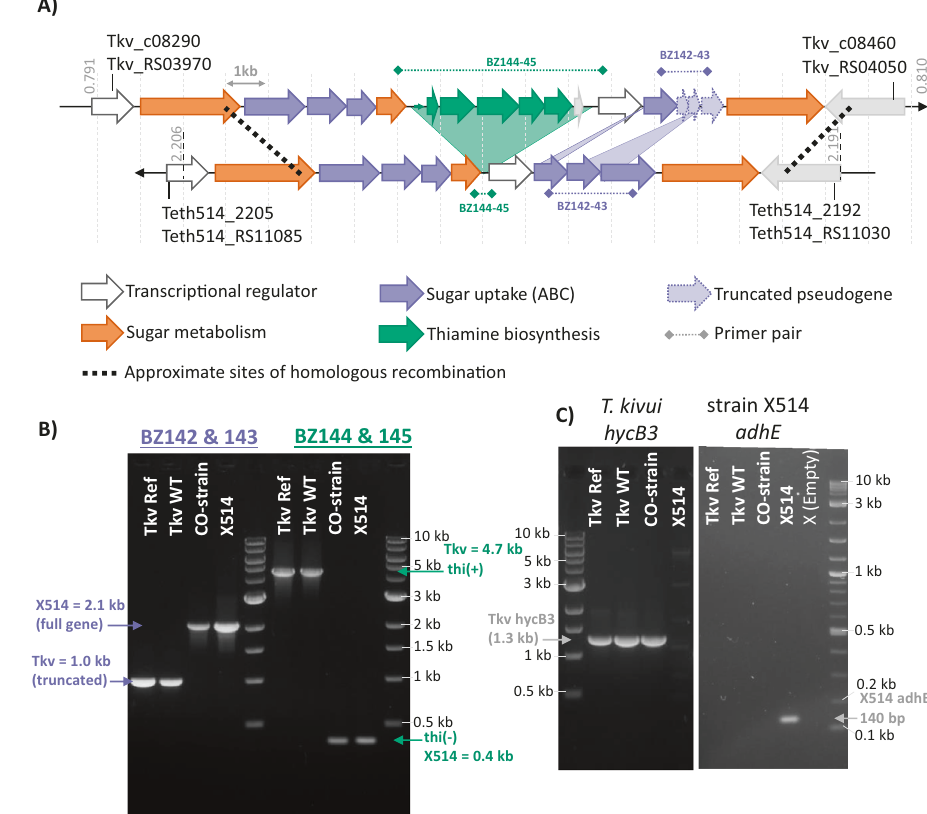
Fig. 2 Comparison of highly mutated genome regions of T. kivui and Thermoanaerobacter sp. strain X514 con fi rm a horizontal gene- transfer event. A Alignment of the T. kivui and Thermoanaerobacter sp. strain X514 genomes reveals high synteny and sequence homology in the region with the majority of SNPs. B Agarose gel electrophoretic separation of PCR products of the ABC-sugar import transporter subunits (purple) and of the thiamine biosynthesis operon (green), obtained by using primer combinations BZ142 and BZ143, or BZ144 and BZ145, respectively. C PCR ampli fi cation of the hycB3 gene speci fi c to T. kivui , and adhE gene speci fi c to strain X514. Genomic DNA puri fi ed from: Tkv Ref = T. kivui DSM2030; Tkv-WT = T. kivui “ wild type ” ( Δ pyrE ) used in this study; CO-strain = T. kivui adapted to CO ( Δ pyrE ); X514 = Thermoanaerobacter sp. strain X514. Marker is NEB 1 kb Ladder, or NEB 1 kb PLUS Ladder (for adhE Sanger sequencing. The resulting PCR product lengths for the CO- strain were not consistent with the published genome (Fig. 2B) as, in addition to the SNPs detected by genome sequencing, several larger insertions and deletions were present. From the PCR, it is apparent that the CO-strain has a roughly 1 kb insertion in the second ABC-transporter cluster (primers BZ142-143) as well as a greater than 4 kb deletion in the thiamine biosynthesis operon (primers BZ144-145) (Fig. 2A). Interestingly, Sanger sequencing of the anomalous length PCR products revealed perfect sequence agreement to the genome of Thermoanaerobacter sp. strain X514, a related strain that differs signi fi cantly in its metabolic properties. Strain X514 produces ethanol from glucose by fermentation as well as other alcohols from organic acids [29] but it does not contain the Wood- Ljungdahl pathway for CO 2 reduction and fi xation, and it therefore does not grow on H 2 + CO 2 [9]. To rule out the possibility of cross contamination, genes speci fi c to T. kivui ( hycB3 ) and strain X514 ( adhE ) were ampli fi ed, con fi rming the absence of adhE in all T. kivui strains and the absence of hycB3 from strain X514 (Fig. 2C). The 16 S sequence perfectly matched the T. kivui 16 S rRNA gene, and contamination was also considered unlikely because the growth capabilities of the CO-strain differ signi fi cantly from strain X514 (see below). It is unclear exactly when contamination occurred in the original experiment [17]. The original sample sent for SNP sequencing consisted of a CO-adapted community (generated by repeated passages, but never isolated), from which